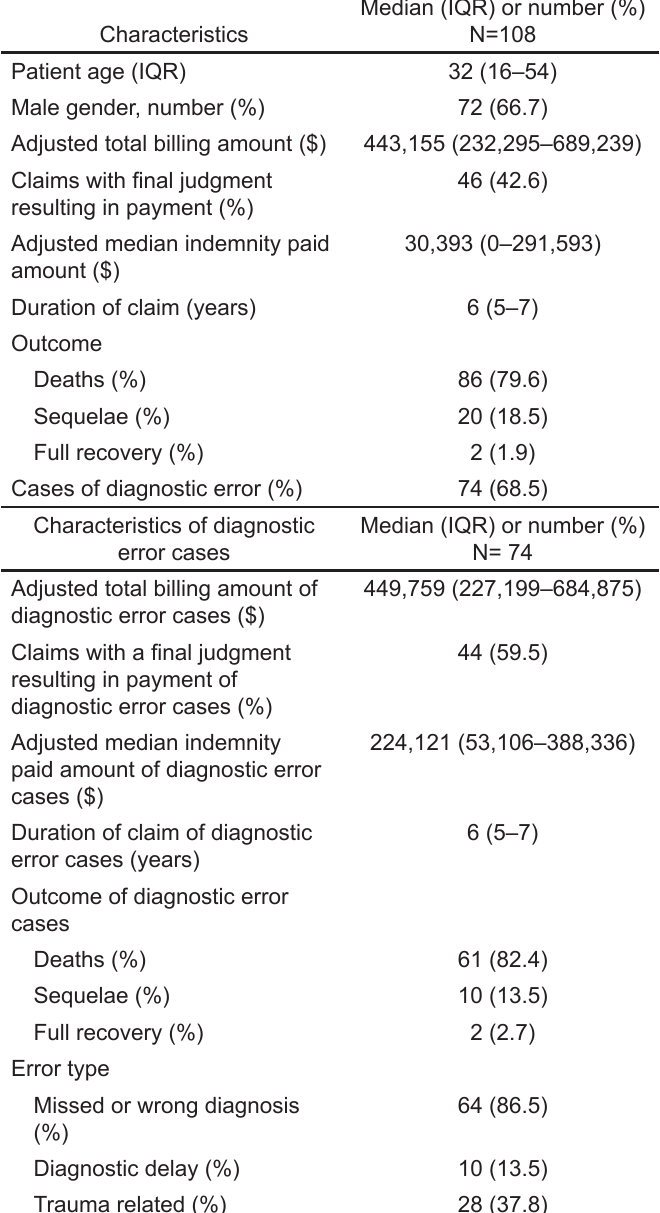
Table 1. Findings of emergency department medical malpractice study in Japan